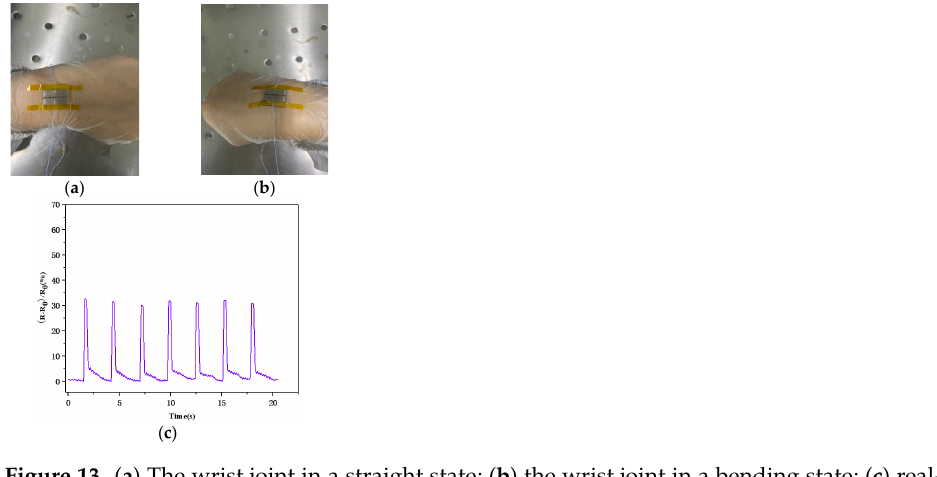
Figure 13. ( a ) The wrist joint in a straight state; ( b ) the wrist joint in a bending state; ( c ) real-time response graph for the flexible pressure sensor attached to the wrist.